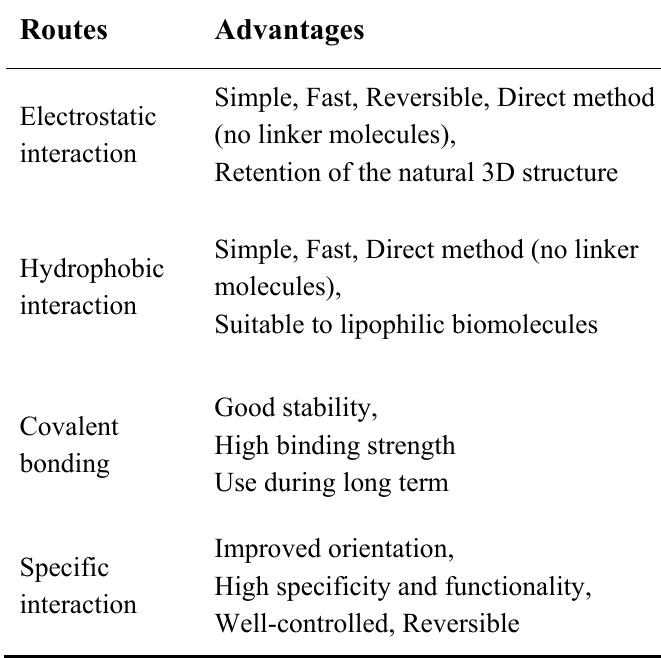
Table 2. Immobilization routes of functional biomolecules on functionalized surfaces.